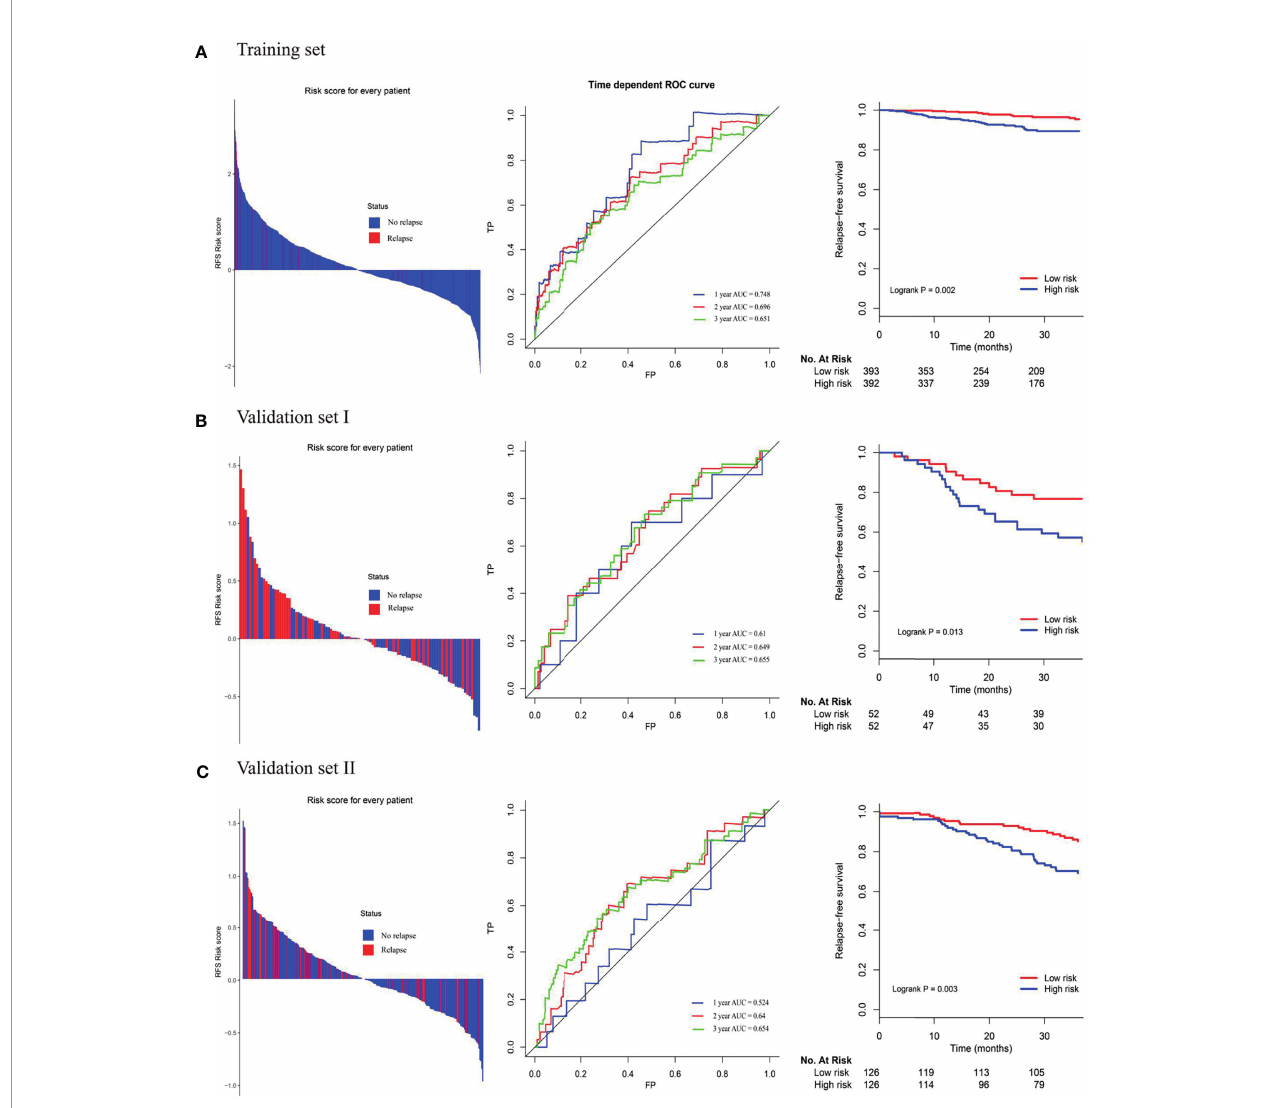
FIGURE 3 | (A) Distribution of risk score, time-dependent ROC curves at 1, 2, and 3 years and Kaplan – Meier survival analysis between patients at low and high risks of relapse in training cohort; (B) fi rst external validation cohort; (C) second external validation